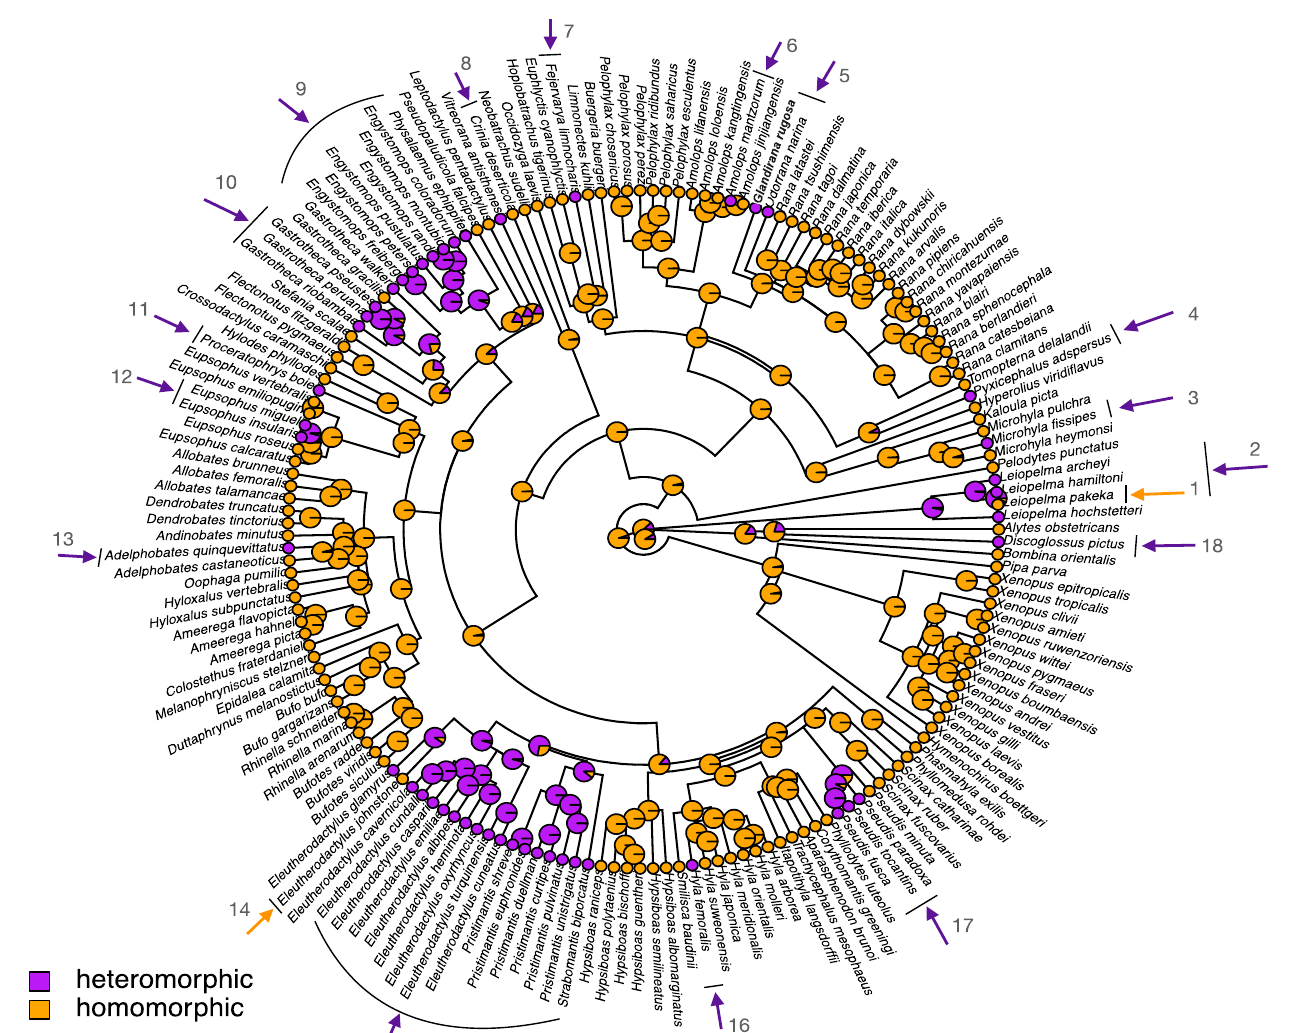
Figure 4. Distribution of homomorphic and heteromorphic sex chromosomes along the phylogeny of studied anurans; see more details in Table S1. Homomorphic sex chromosomes are indicated in orange, and heteromorphic in purple. The tree is obtained from http://www.timetree.org/, accessed on 5 February 2021 and the ancestral state reconstruction of sex chromosome morphology is analyzed and visualized with the “Phytools” package in R (version 3.6.3), using a stochastic mapping approach with the ER (equal rate) transition rate model, suitable for binary character traits [48,49]. Pie charts display the posterior probabilities of sex chromosome types on each node of the phylogenetic tree. Numbered arrows indicate transitions in sex chromosome morphology, purple arrows indicate from homomorphy to heteromorphy, and orange arrows from heteromorphy to homomorphy.